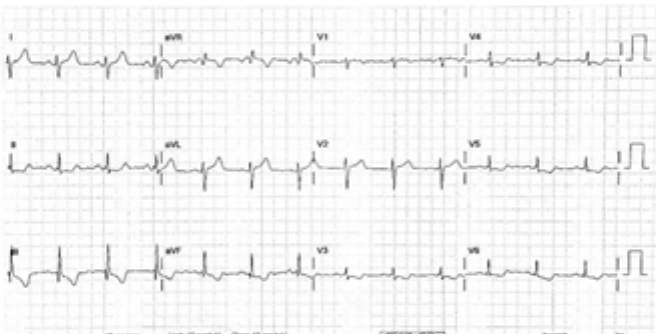
Figure 2. Post-nitroglycerine electrocardiogram with interval improvement of ST-elevation myocardial infarction.